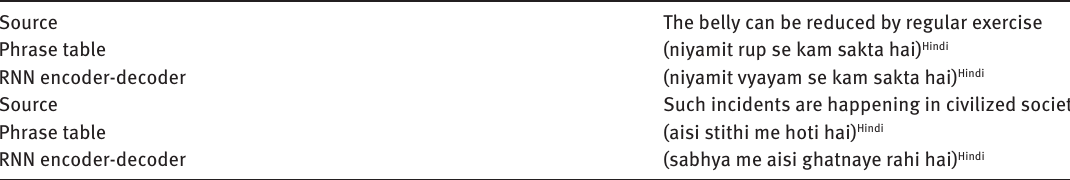
Table 2: Top Scoring Phrases for the Translation Model and Encoder-Decoder.